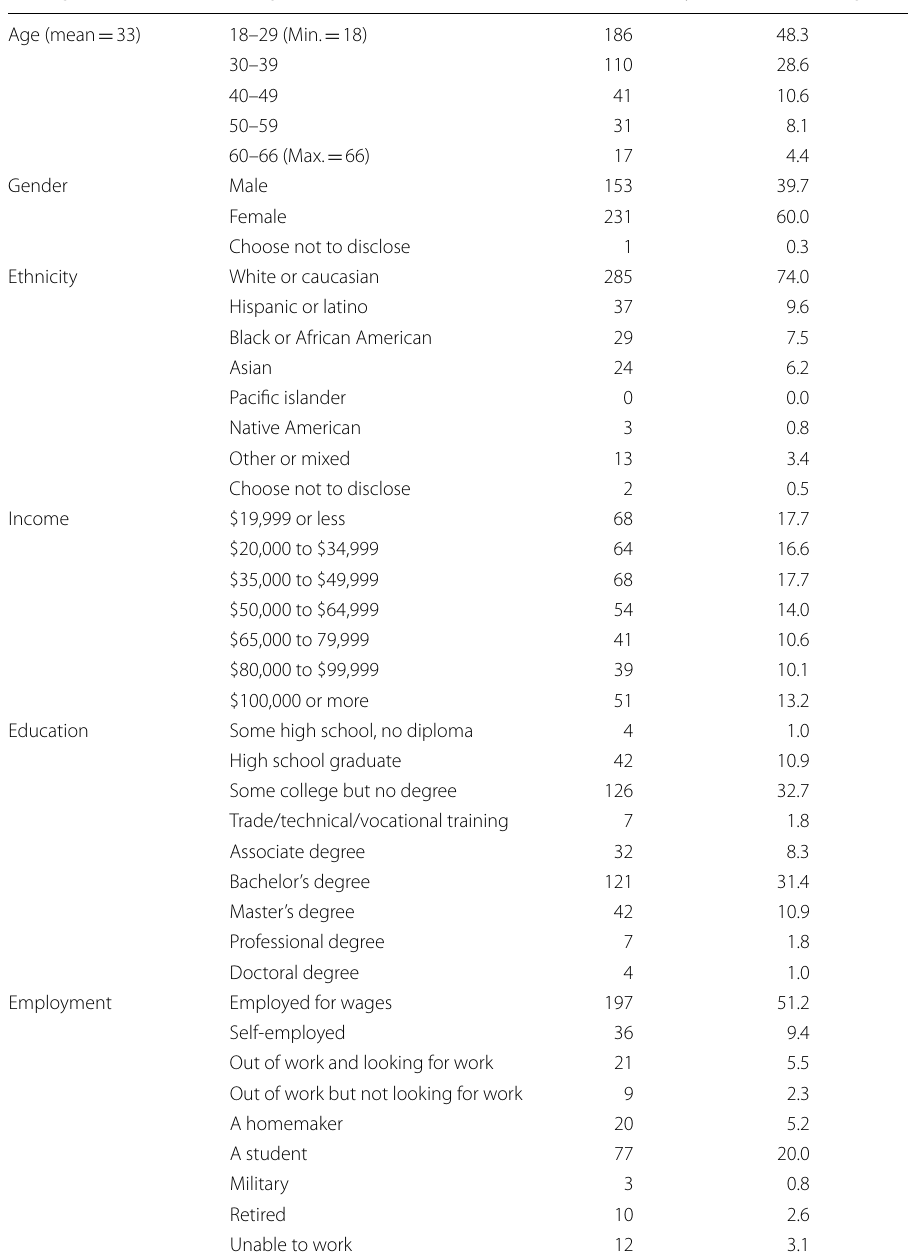
Table 2 Demographic characteristics of survey